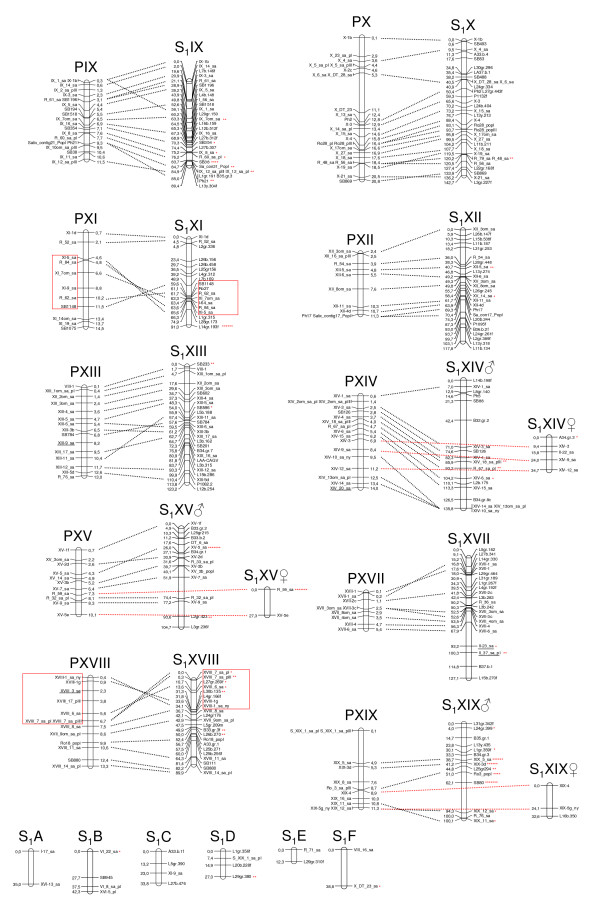
The last eleven linkage groups (LGIX - LGXIX) of the consensus S1 linkage map aligned to the poplar physical map. The willow consensus S1 linkage map aligned to the poplar genomic sequence (prefixed with P) based on SNP, microsatellite and AFLP markers with approximate positions of markers given in base pairs (bp) and centimorgans (cM) respectively. Loci that may indicate syntenic disparities are underlined. Willow linkage groups S1A to S1F that could not be aligned to the poplar genome are also shown. Markers showing segregation distortion are indicated by asterisks on the willow map (one asterisk: P < 0.1, two asterisks: P < 0.05, three asterisks: P < 0.01: four asterisks: P < 0.005, five asterisks: P < 0.001, six asterisks: P < 0.0005, seven asterisks: P < 0.0001). Two inversions are indicated by boxes.